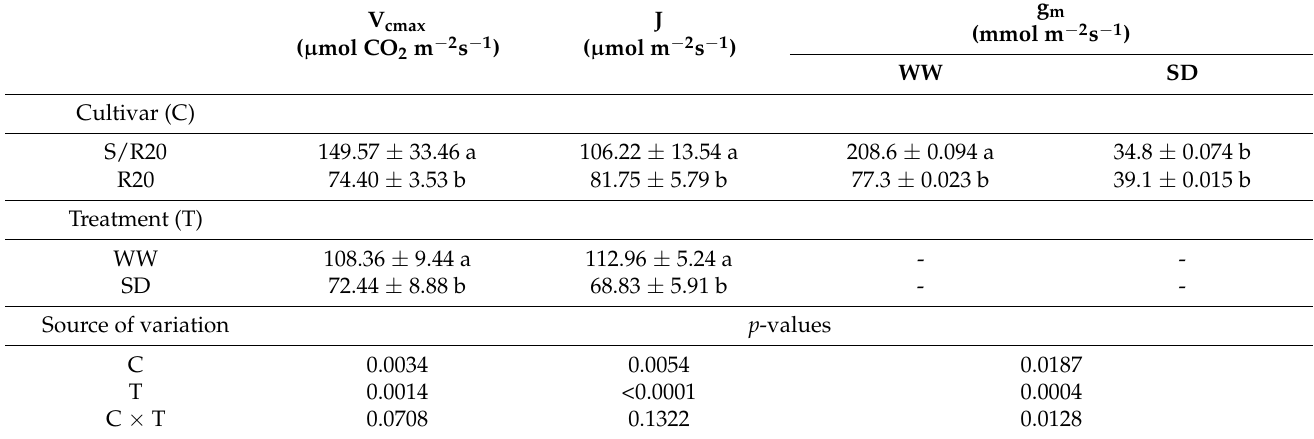
Table 2. Mean ( ± standard error) values of leaf photosynthetic traits measured at the end of the SD experiments, sources of variation, and p -values of Prunus cultivars subjected to substrate desiccation. V cmax : maximum rate of Rubisco carboxylation, J: electron transport rate, g m : mesophyll conductance to CO 2 . Different letters indicate statistical differences among means ( p ≤